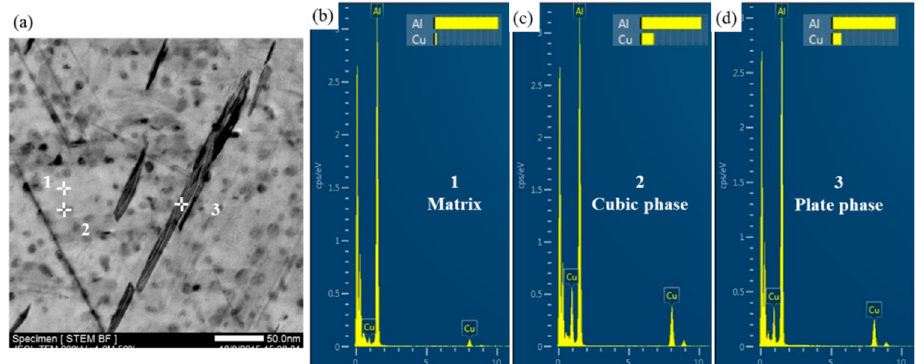
Figure 7. ( a ) TEM image of the precipitates in Ce-free alloy after exposure at 120 ° C for 1300 h; STEM-EDS analysis of the matrix ( b ), cubic phase ( c ), and plate phase ( d ) as point 1, point 2, and point 3, respectively.